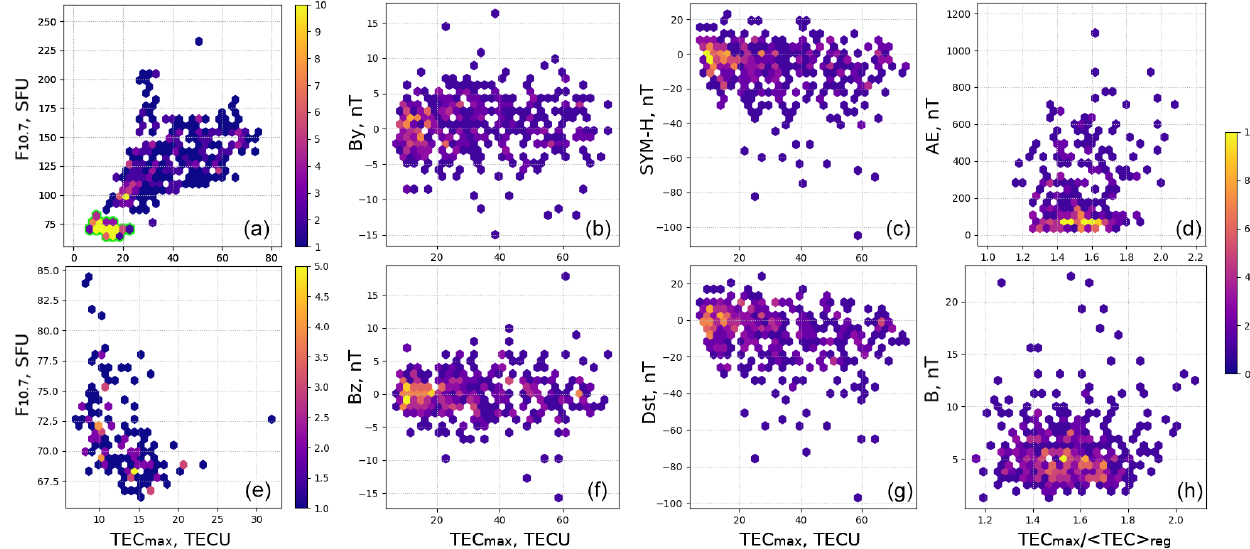
Figure 5. The distributions of the maximal TEC values in a region from 30 ◦ W to 60 ◦ E and from 30 to 60 ◦ S versus 10.7nm solar radiation (a, e) , the B y (b) and B z (f) components of the IMF, the SYM-H (c) and Dst (g) geomagnetic indices; and the distributions of the maximal to the regional mean TEC ratio versus the AE index (d) and B (h) . All of the TEC values are taken at 10:00UT during 2014, 2015 and 2018. The distribution in panel (e) is made with data from 2018 only; these data are highlighted using green in panel (a)